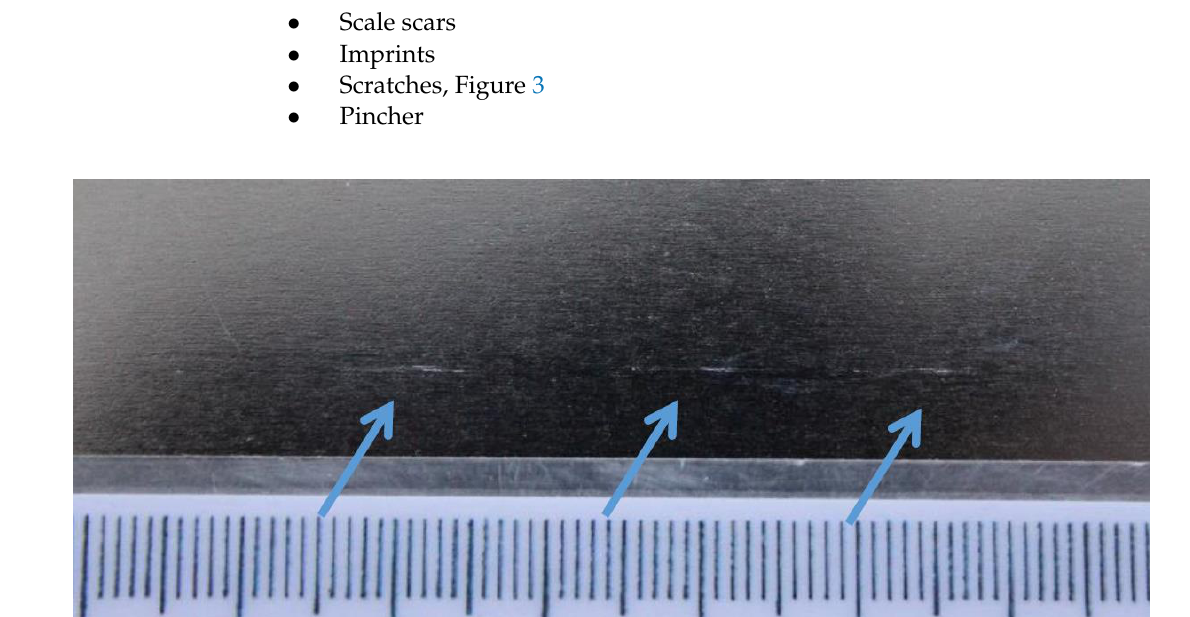
Figure 3. Scratches resulting from the steel-strip cold-rolling process.